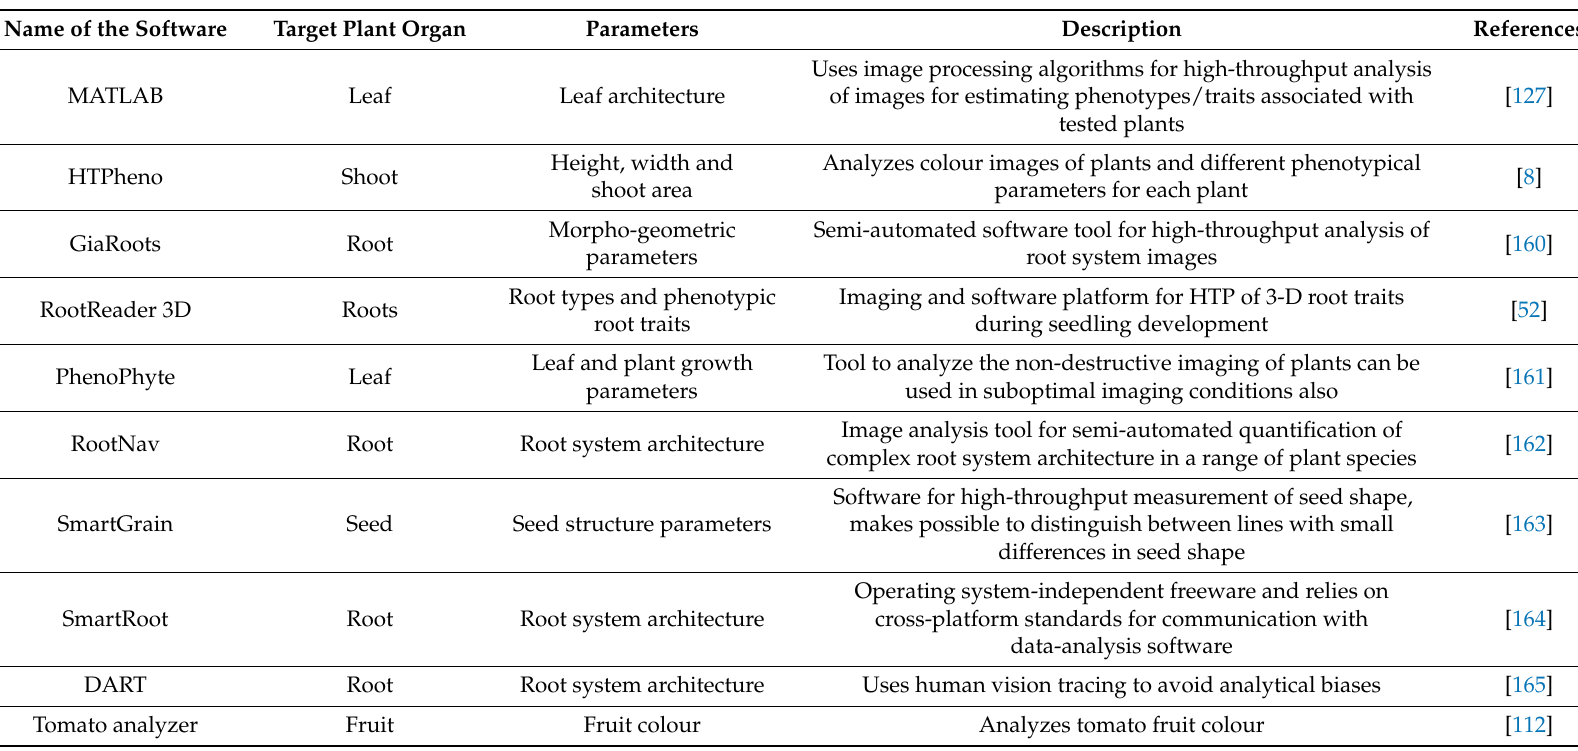
Table 2. Non-exhaustive list of popular software packages used for advanced analysis of morphometric parameters captured using common HTP